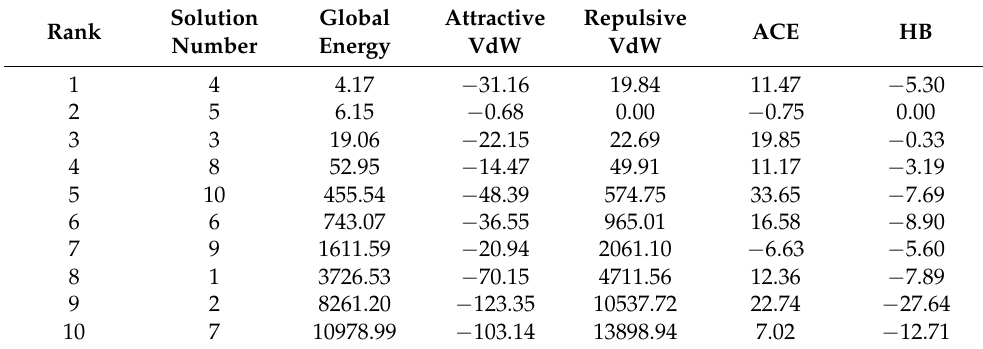
Table 10. MHC-I-vaccine FireDock solutions. Energy is measured in KJ · m − 1 for each term listed below.